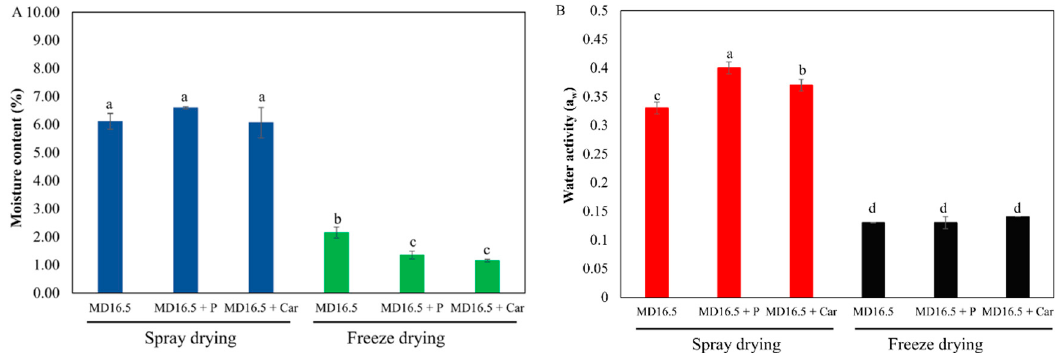
Figure 5. ( A ) Moisture content (%) of the powders produced by spray-drying and freeze-drying, ( B ) water activity (a w ) of the powders produced by spray-drying and freeze-drying. MD: Maltodextrin 16.5–19.0 DE; P: Soybean protein; Car: ι -carrageenan; Bars followed by different letters are significantly different at P < 0.05, according to the Duncan’s test.